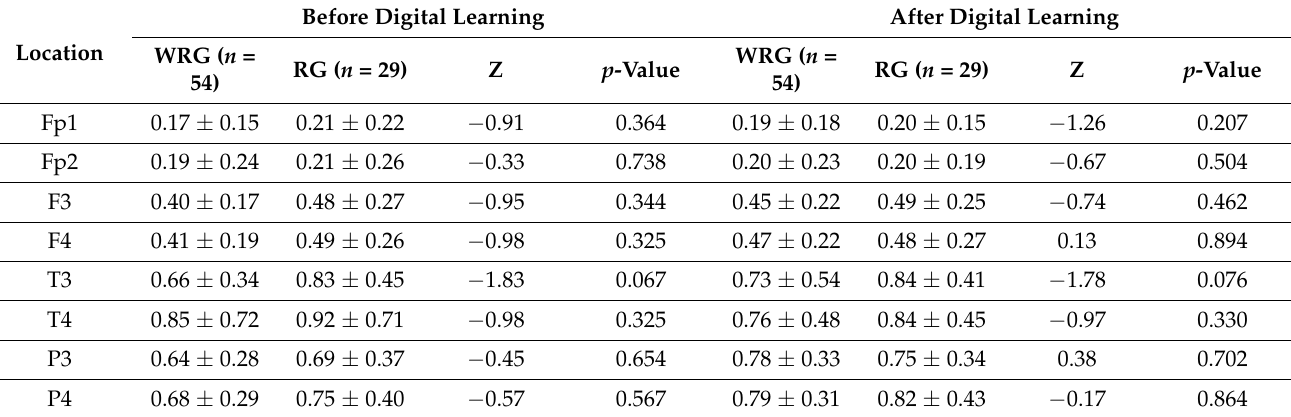
Table 2. Differences in attention between the without-risk and risk groups (WRG and RG, respectively) ( N = 83). Before Digital Location